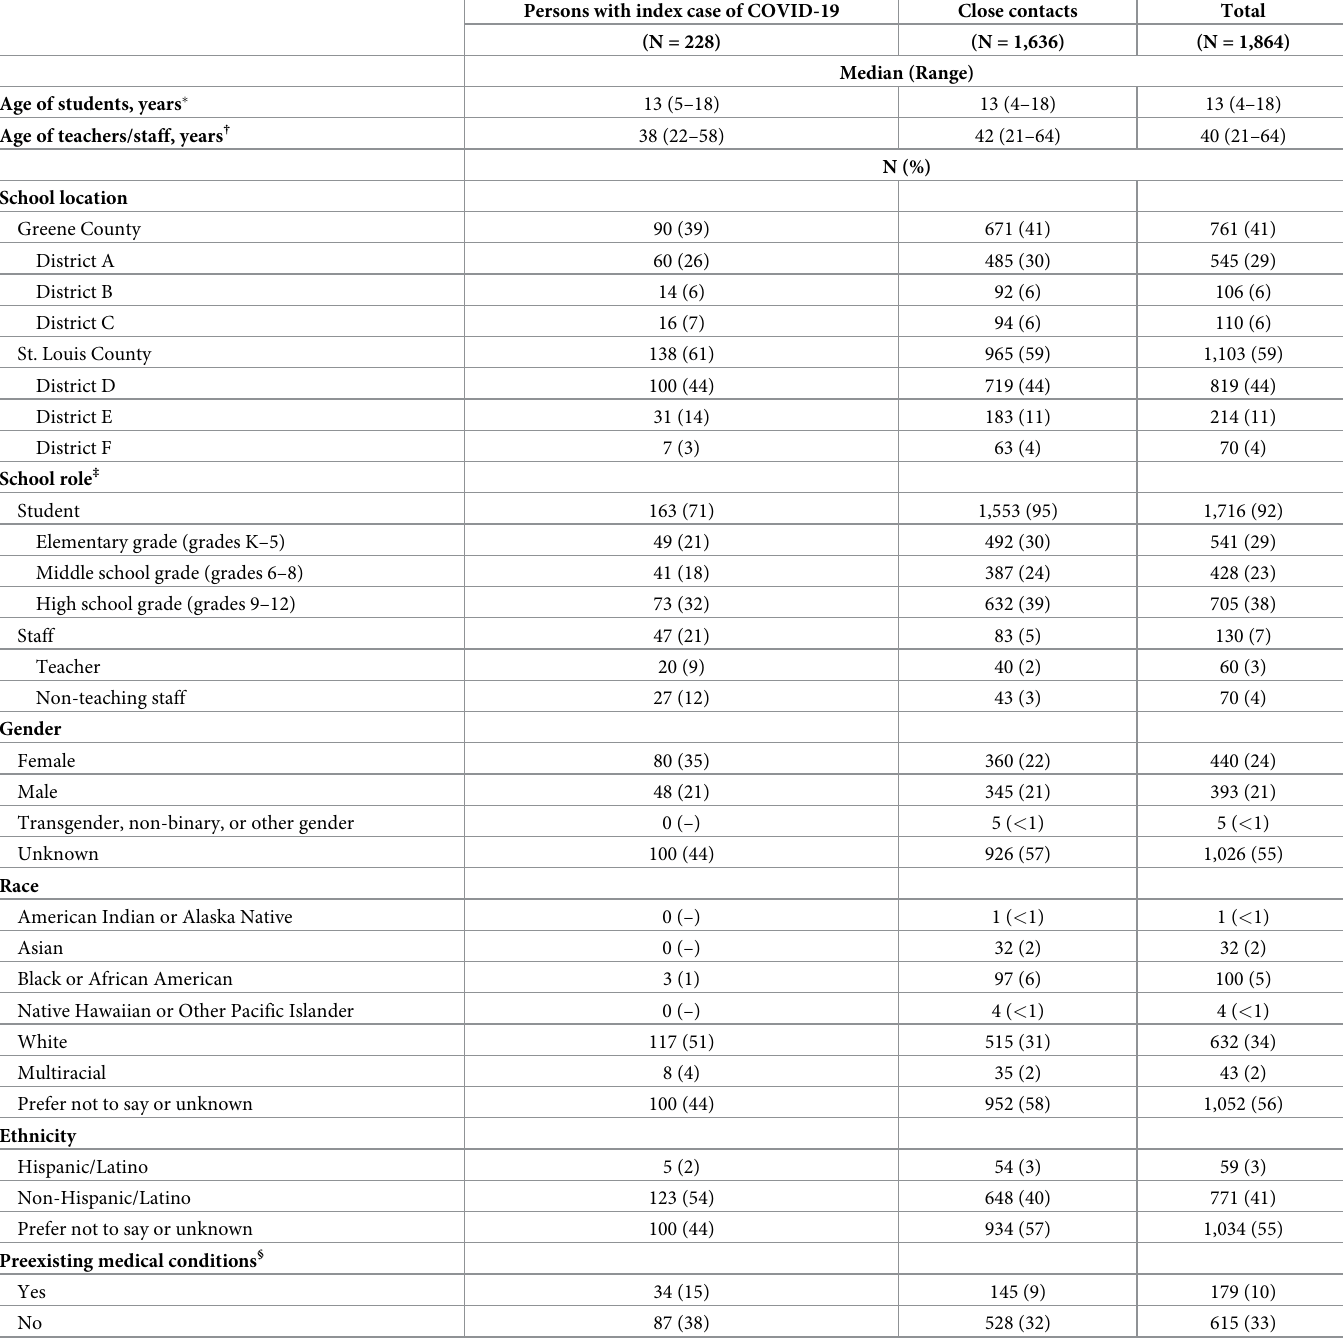
Table 1. Characteristics of school-based persons with index cases of COVID-19 and close contacts from 103 K–12 schools, Greene and St. Louis Counties, Missouri, January 25–March 21,